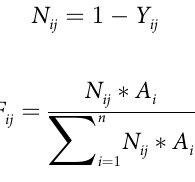
deviation and obstacle degree, were introduced to diagnose obstacles. The factor contribution degree represents the influence of a single index on the total goal, which is generally expressed by the weight A of the single index. The index deviation N represents the difference between i ij the value of the single index and the ideal target value and is expressed by the difference between the standardized value of the single index Y and 100%. The obstacle degree F indi- ij ij cates the degree to which each individual index represents an obstacle to land-based ecological security. The formula for the obstacle degree is shown below as Eqs (14) and (15), and the results are shown in Table 13.